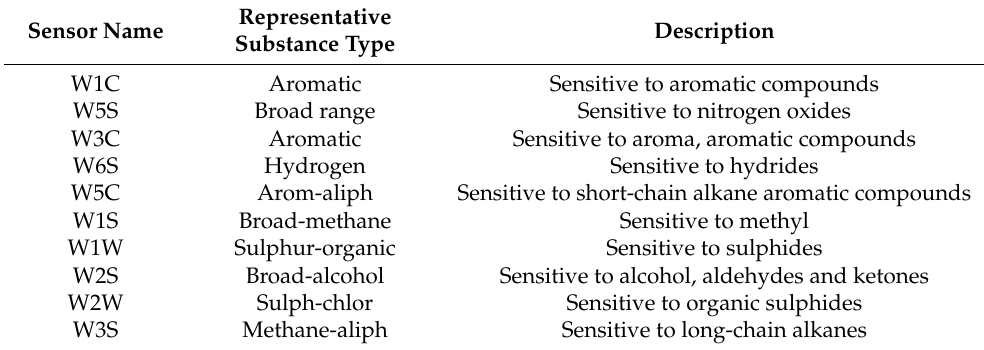
Table 2. The information on ten electronic nose